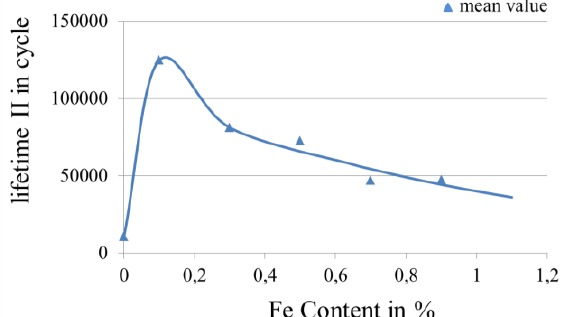
Figure 18. Effect of Fe content in gold layer on lifetime in fretting and wear test. Number of measurements: